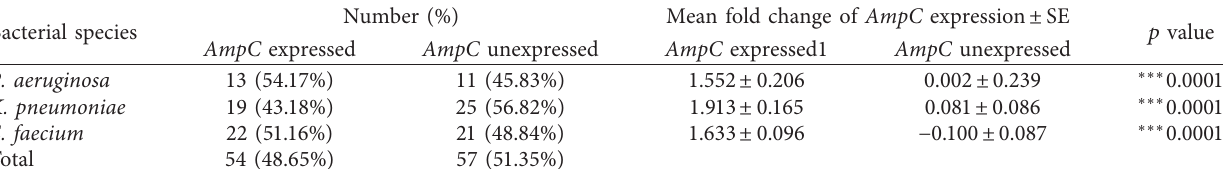
Table 4: Mean fold change in differential expression of AmpC ( AmpC expressed vs. AmpC unexpressed) among the bacterial species included in this study.